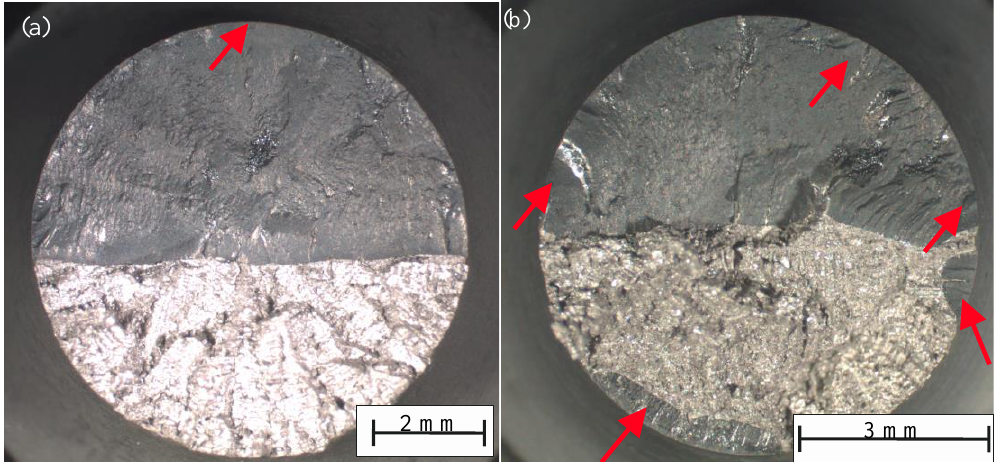
Figure 8. Crack initiation sites of a notched specimen fatigued with ( a ) low total strain amplitude, ( b ) high total strain amplitude at 850 °C.